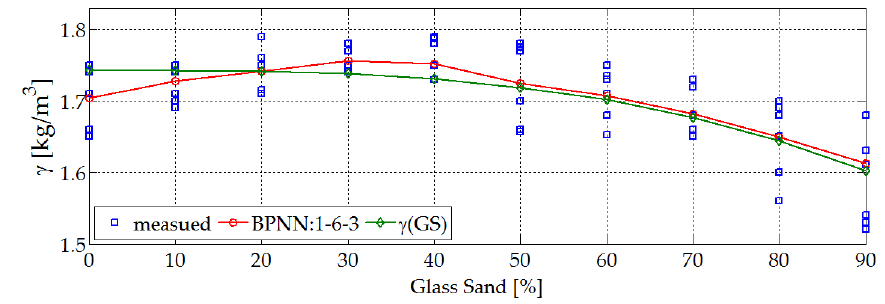
Figure 9. Bulk density ( γ ) as a function of glass sand content.